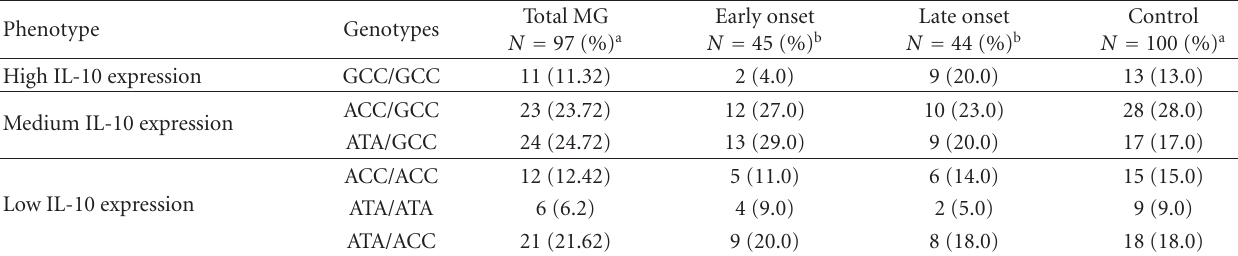
Table 4: IL-10 genotype frequencies in the complete cohort of MG patients (i.e., total MG), the subgroups of early and late onset MG and controls.